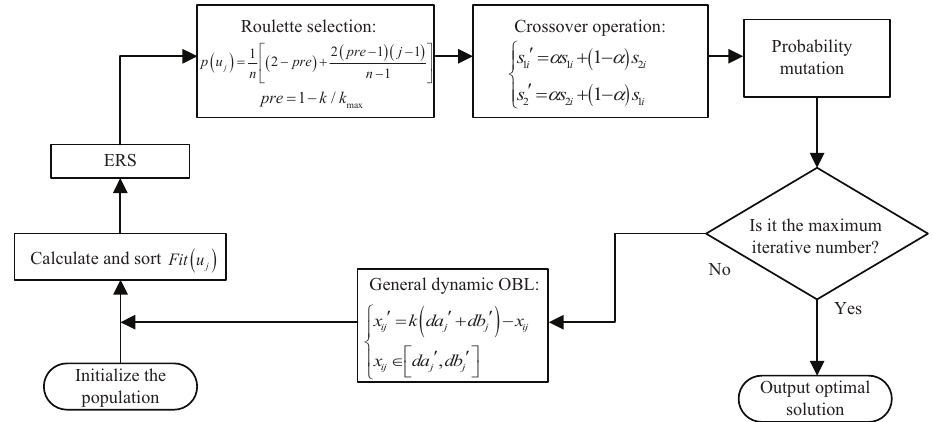
Figure 7. The flow chart of improved genetic algorithm